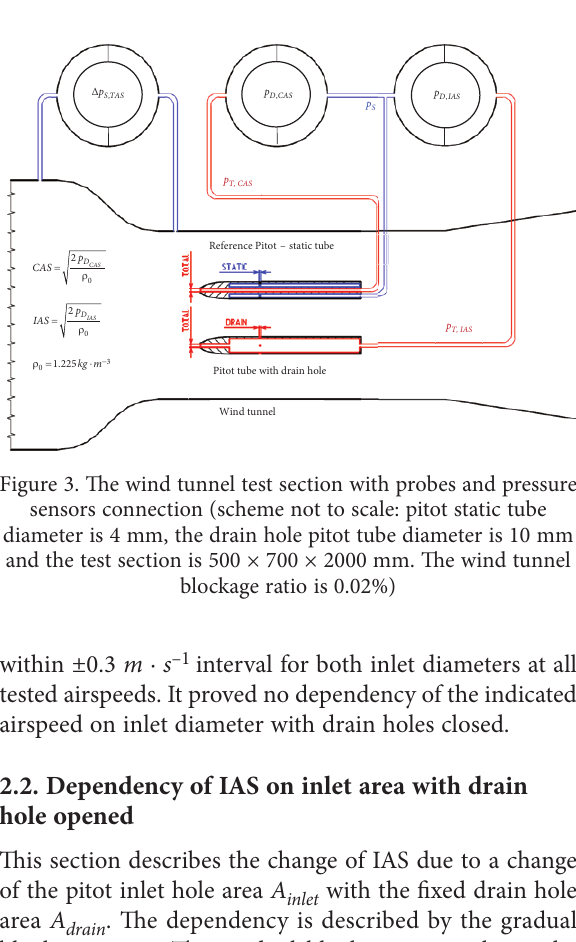
Figure 1. Pitot tube wind tunnel installation (left) and ten pitot tubes with various inlet diameters (right)